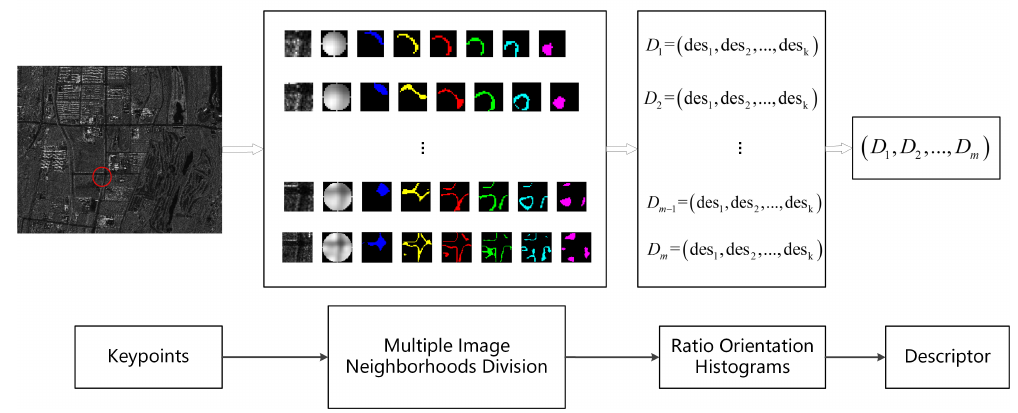
Figure 2. Flow chart of the construction of the proposed descriptor.